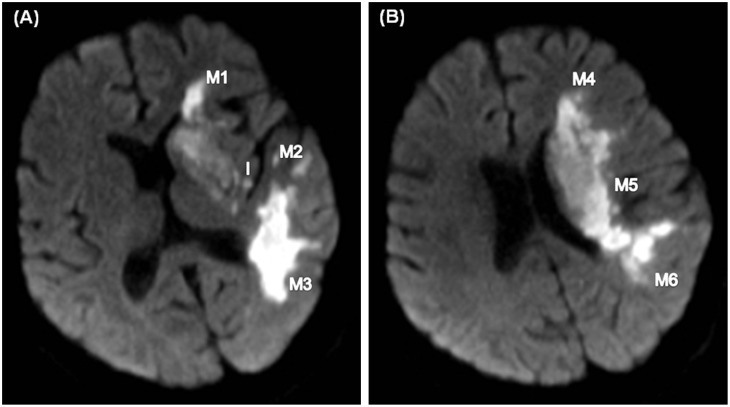
Same patient as in Fig 1 The second diffusion-weighted imaging study reveals new or larger infarct areas in the internal capsule, insula, lentiform nuclei, and zones M1 to M6.The infarct growth score was 1 (10–3–6 = 1). The second diffusion-weighted image (A, B) at the basal ganglion and suprabasal ganglion levels reveals infarct growth in the insula and zones M1 to M6.